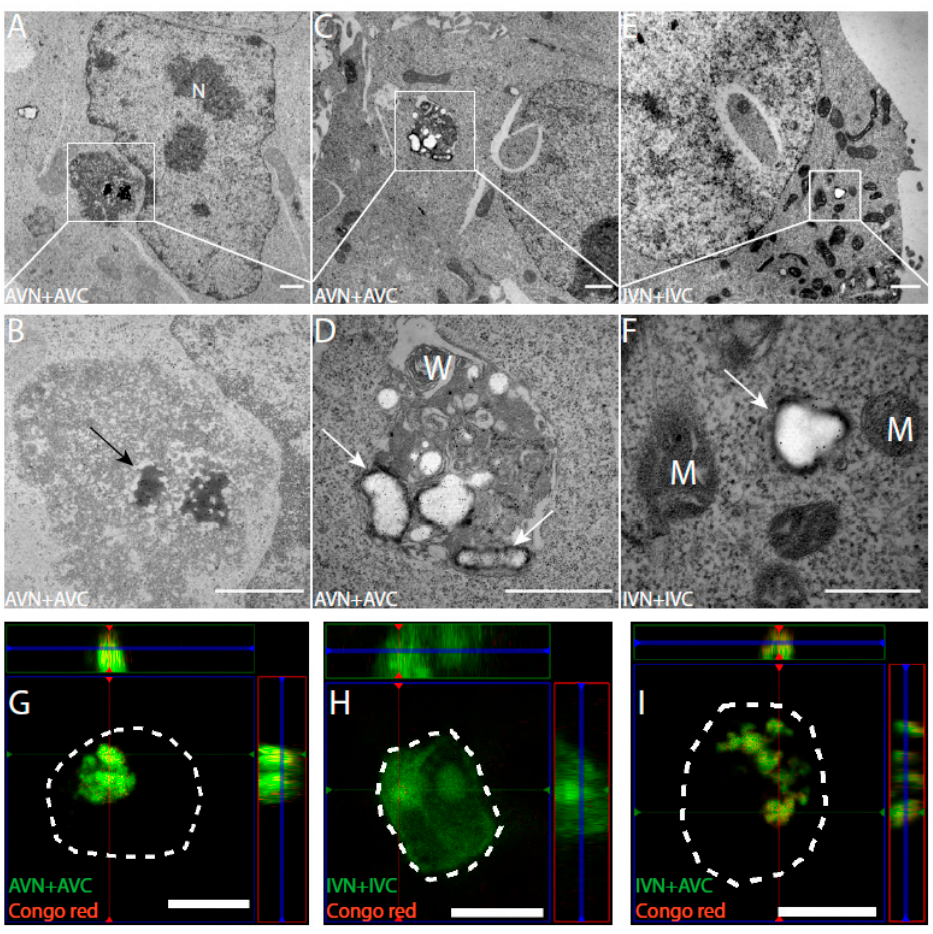
Figure 2. Transfection with AVN + AVC results in electron-dense fibrillary aggregates with an affinity for Congo red. The immuno-TEM analysis of HEK293 cells transfected with ( A – D ) AVN + AVC and ( E , F ) IVN + IVC. ( A , B ) Electron-dense aggregates with A β immunoreactivity (black arrow) located adjacent to the cell nucleus. ( C , D ) Amorphous structures with A β immunoreactivity (white